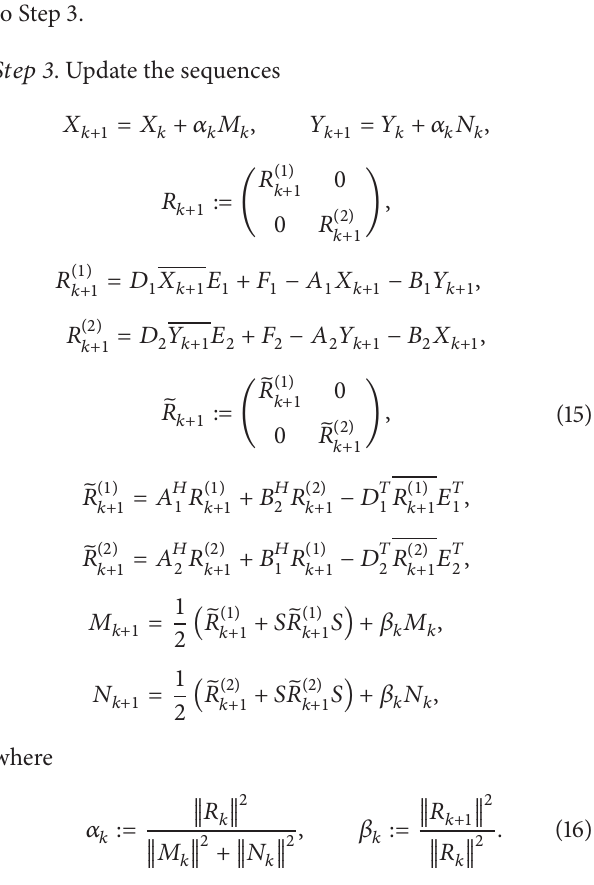
Algorithm 3 (MCG method for centrally symmetric matrix